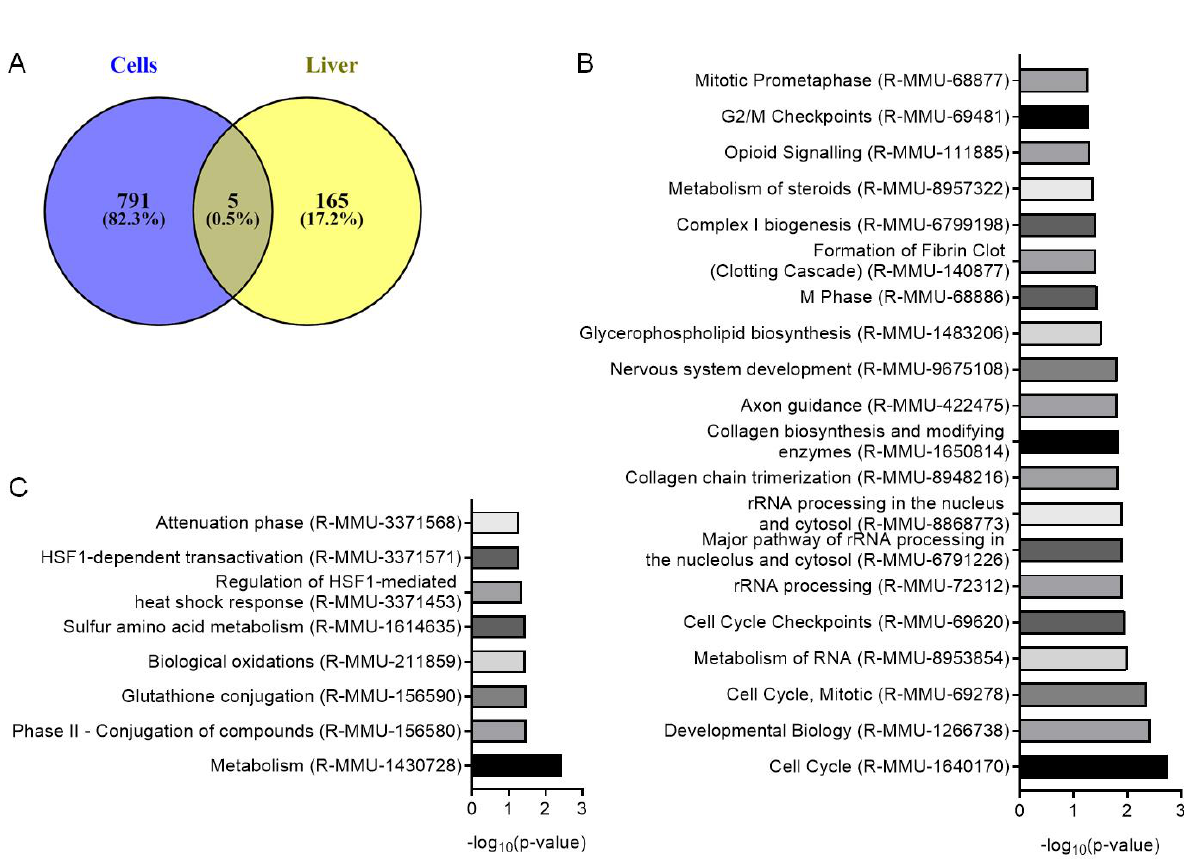
Figure 2. Results of transcriptome analysis of AML12 cells and murine liver after LL35 depletion. ( A ) Venn diagram for differentially expressed genes after LL35 knockdown in AML12 cells in comparison with murine liver. Top representative pathways with p -value < 0.05 obtained by PANTHER Reactome analysis of differentially expressed genes after LL35 depletion in ( B ) AML12 cells; ( C ) murine liver.